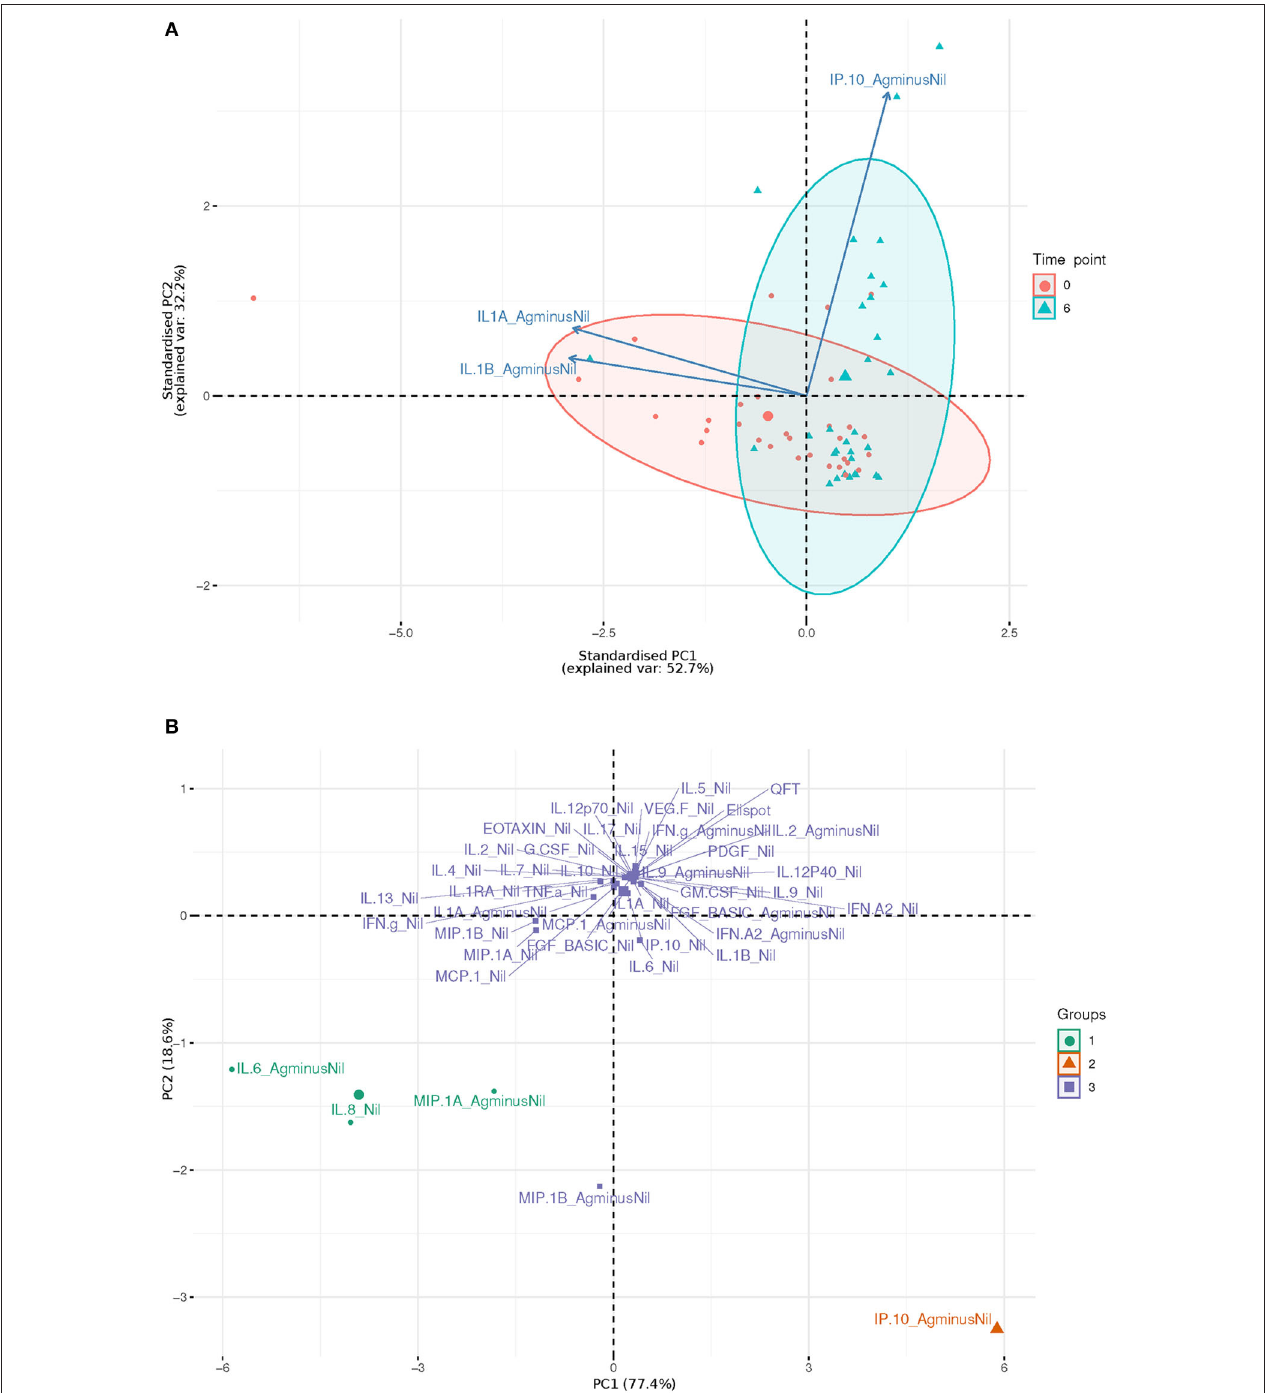
FIGURE 3 | First two principal components plots: (A) Over three most significantly changing analytes (arrows) between day 0 (red) and 6 months (blue), each dot representing a patient sample. (B) Over each analyte of interest and all time points, grouped by K-means clustering, using K = 3, each dot representing a compound.